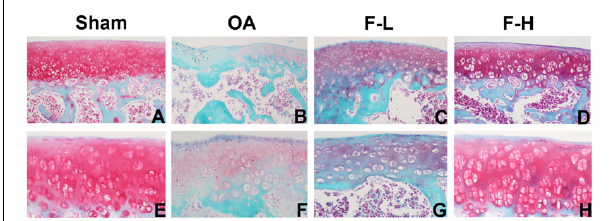
TABLE 1 | Primers for real-time PCR.